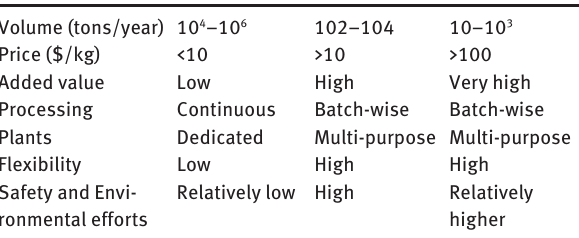
Table 1 Difference in characteristics of bulk chemicals vs. fine